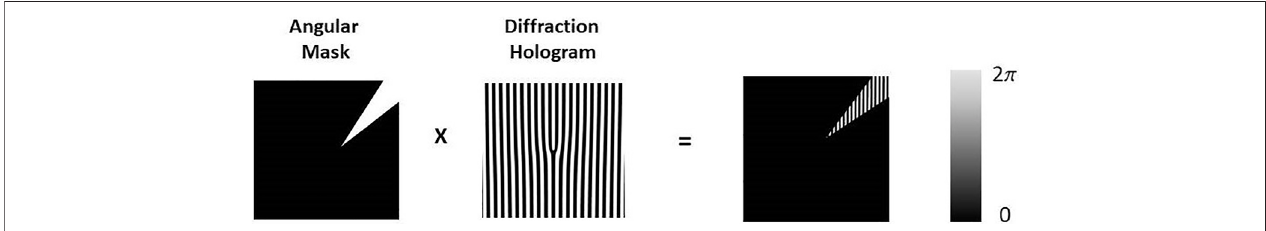
FIGURE 6 | Angular masks used to create path-entanglement and diffraction holograms used to analyze the OAM spectrum. Both the angular mask and the diffraction hologram can be programmed using the same Spatial Light Modulator. Details are in the